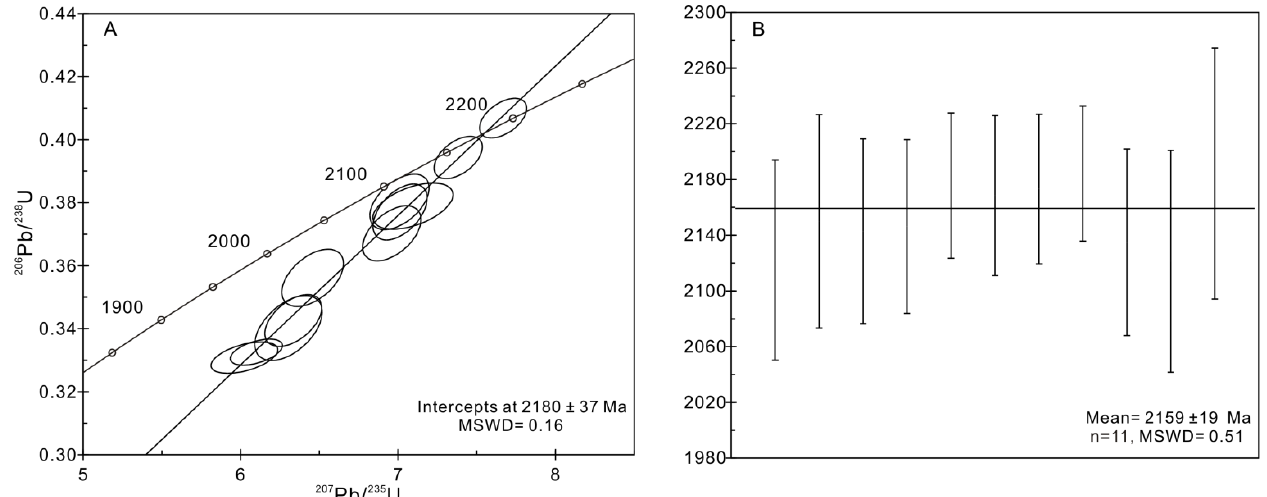
Figure 8. U-Pb Concordant diagram ( A ) and weighted average diagram ( B ) for Tongkuangyu granodiorite porphyry.